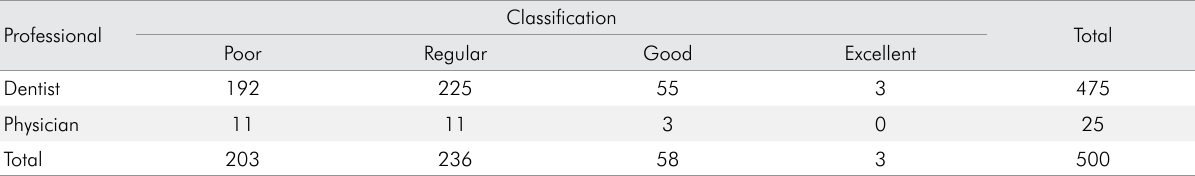
Table 4. Classification of referral letters according to the profession.